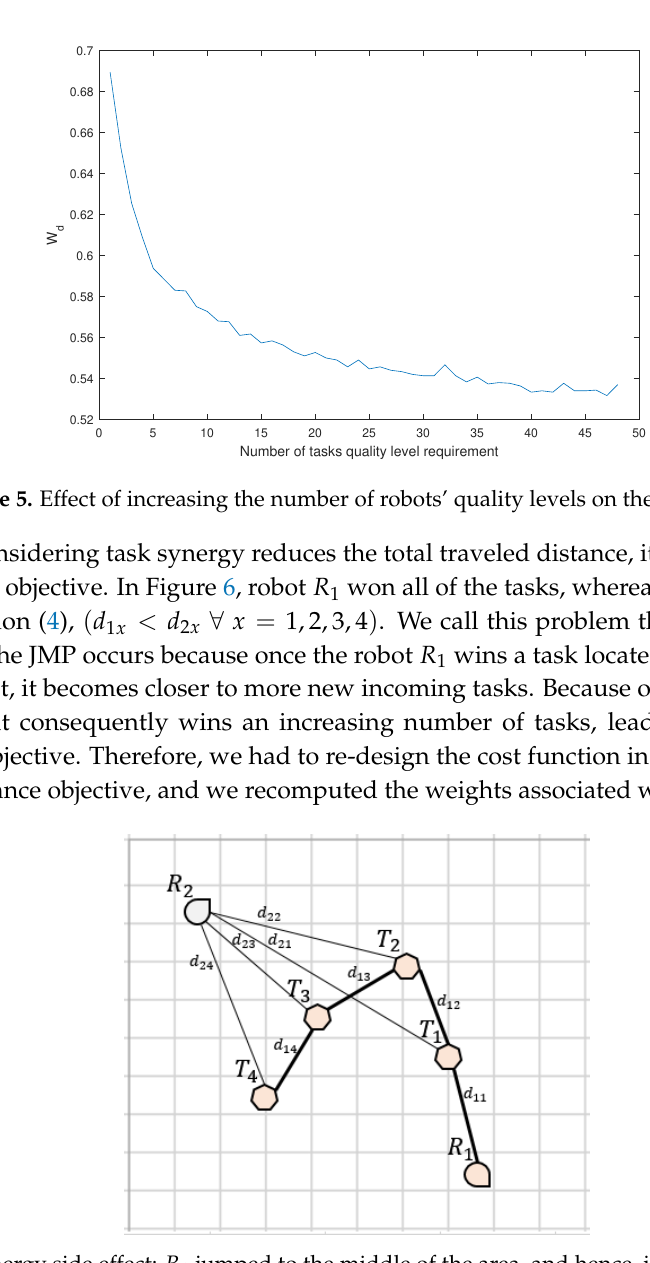
Figure 6. Synergy side effect: R 1 jumped to the middle of the area, and hence, it occupied all